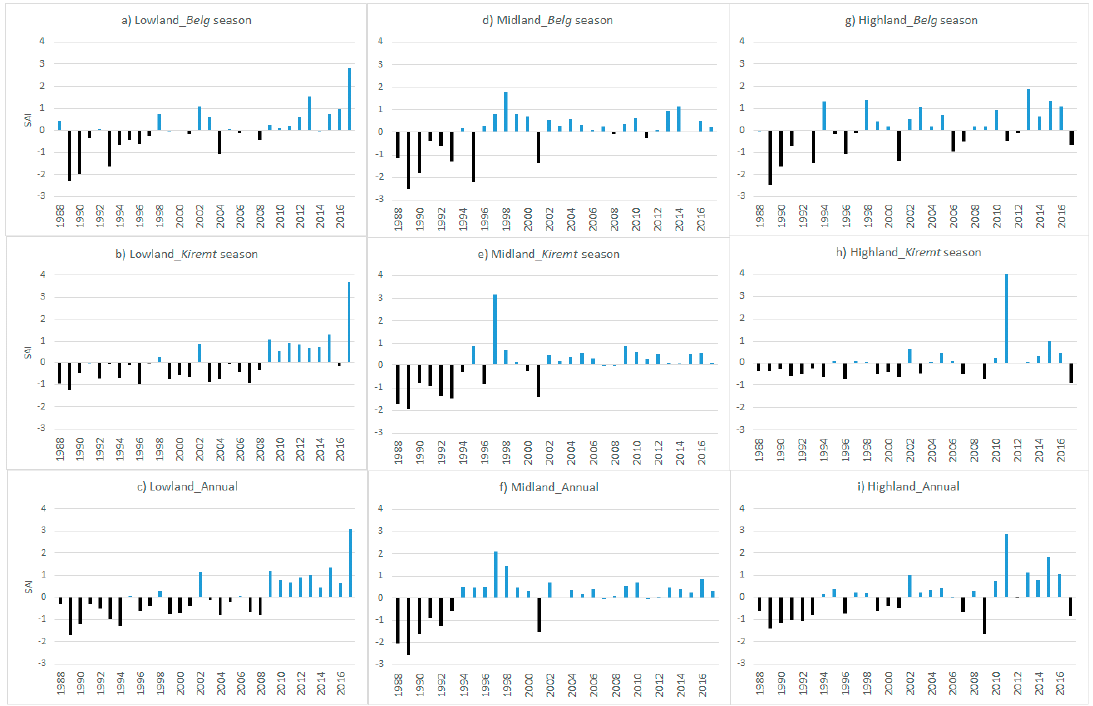
Figure 2. Trends of standardized anomaly index of average annual temperature by agro-ecological settings and season (1988–2017).